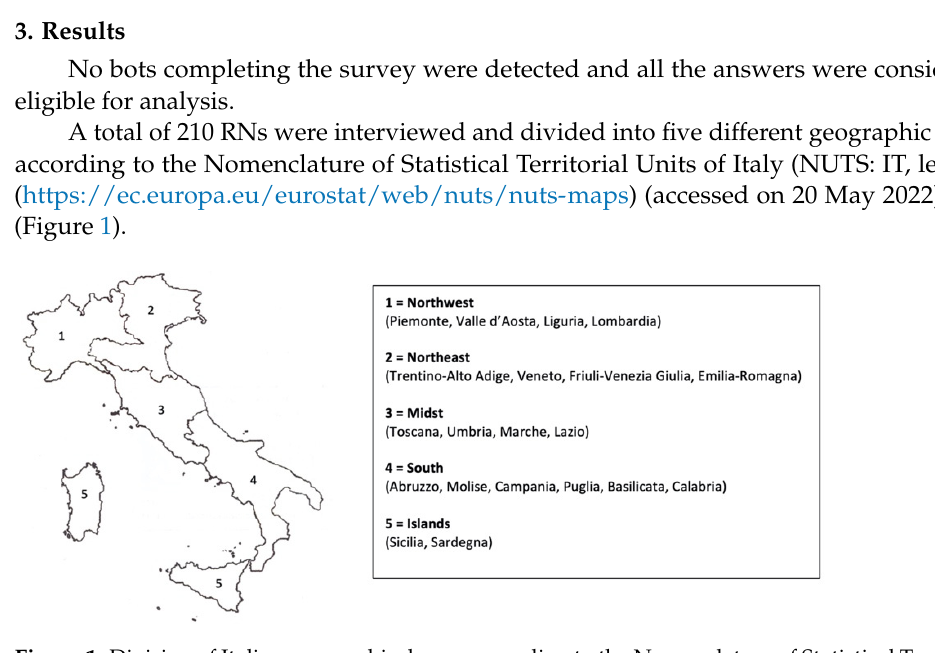
Figure 1. Division of Italian geographical areas according to the Nomenclature of Statistical Territorial Units of Italy (NUTS: IT).